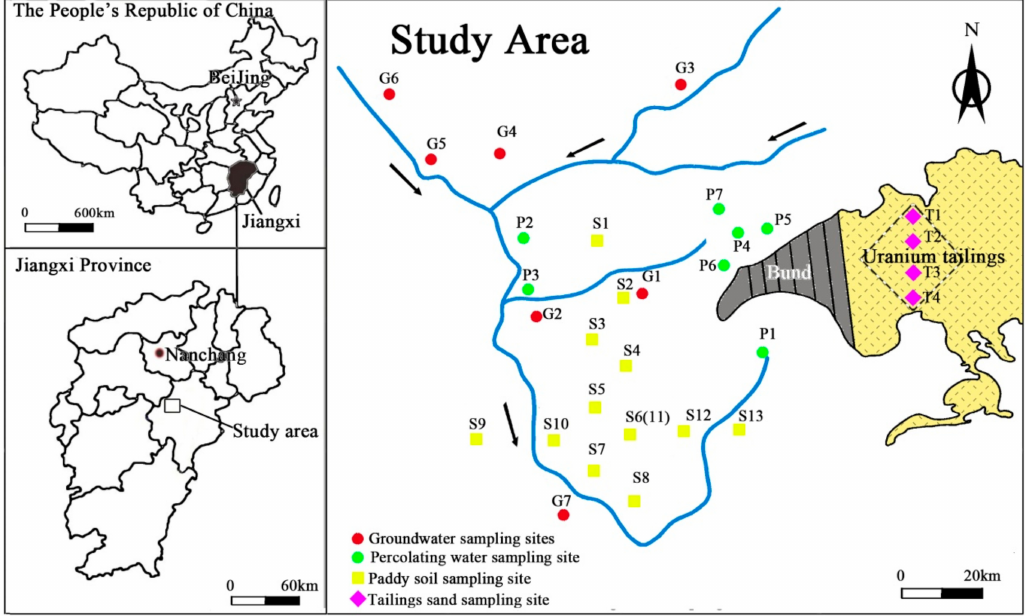
Figure 2. Location of sampling